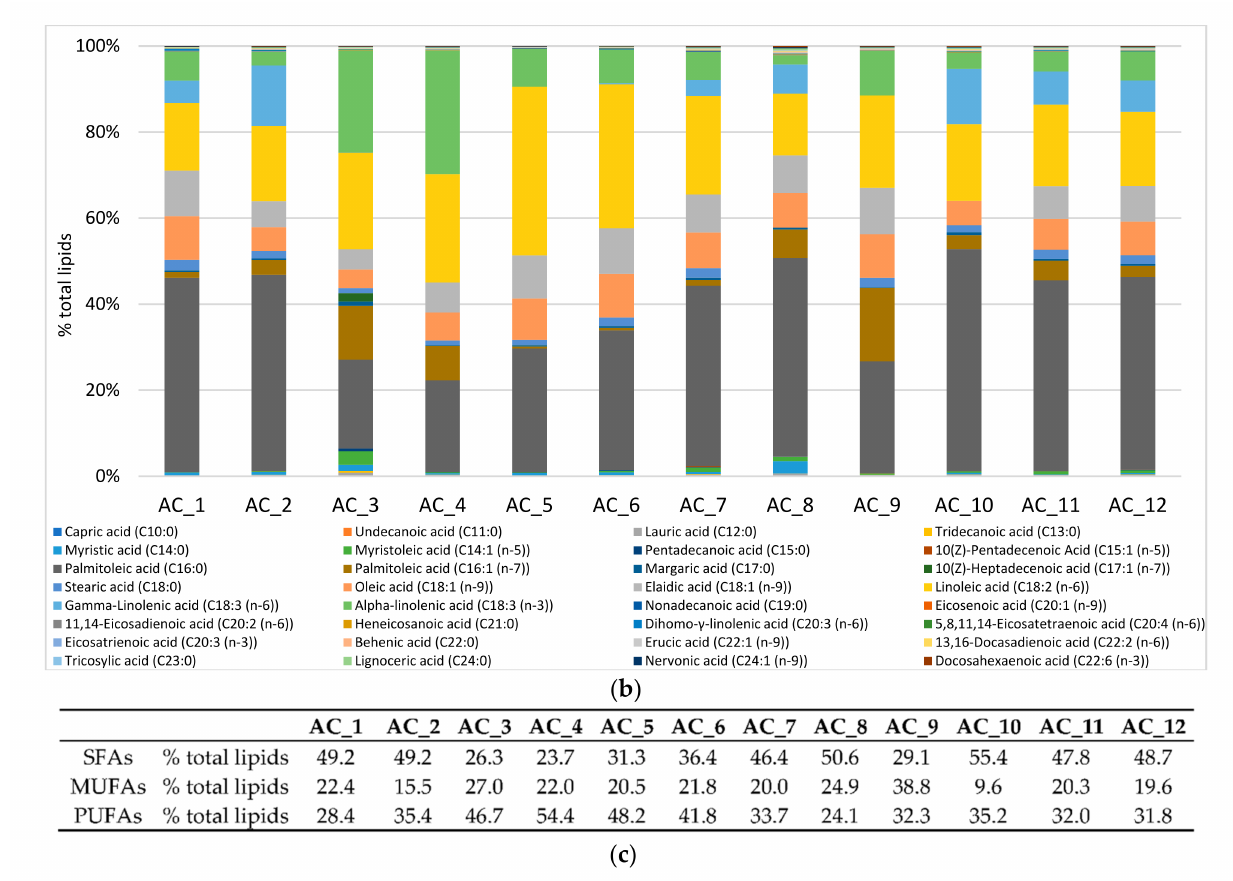
Figure 1. ( a ) Amino acid speciation, ( b ) fatty acid speciation and ( c ) summary of fatty acid